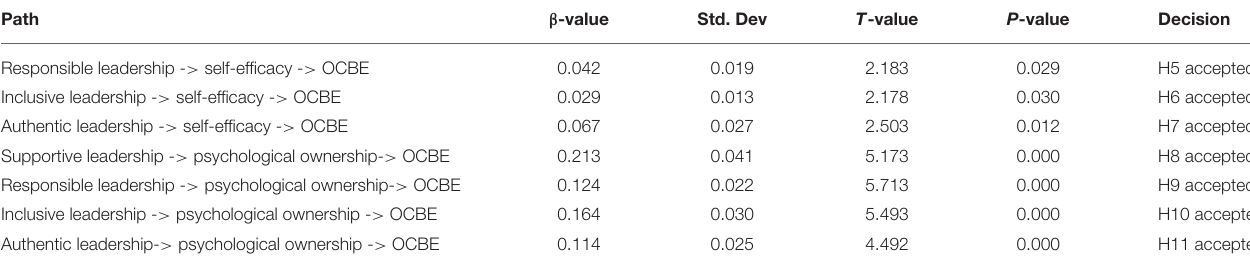
TABLE 6 | Specific indirect effect. Path β -value Std. Dev T -value P -value